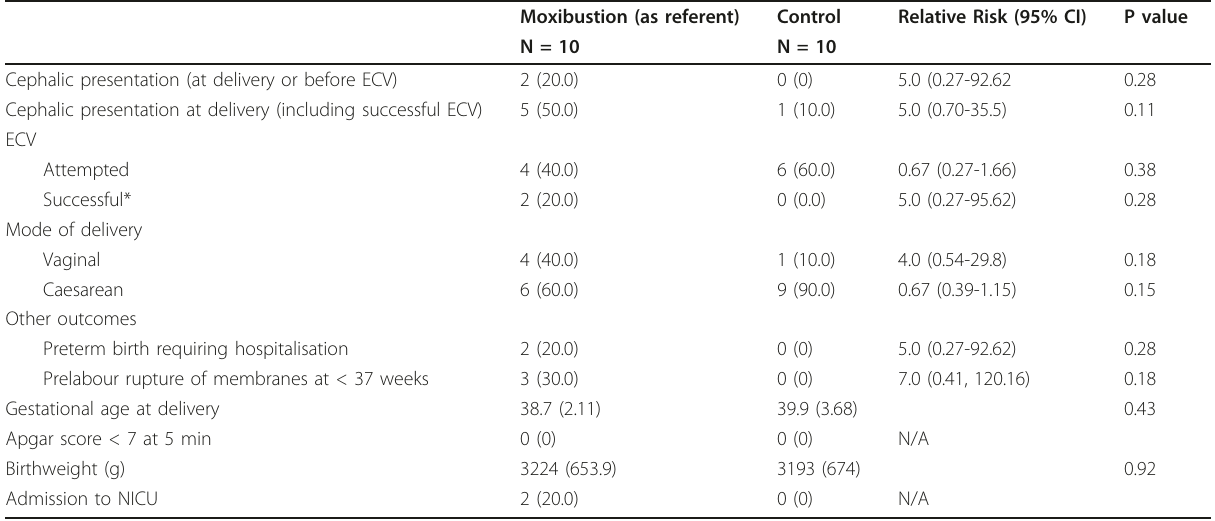
Table 2 Comparison of Outcome Measures Between Moxibustion and